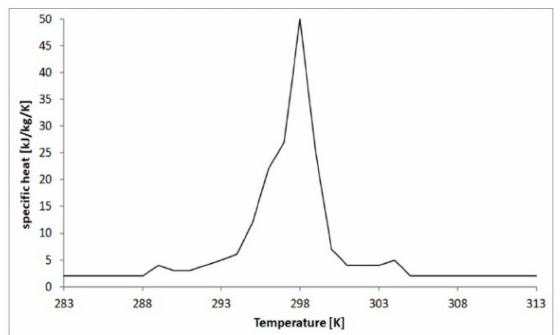
Figure 3 . Specific heat of used PCM. Figure 3. Specific heat of used PCM.